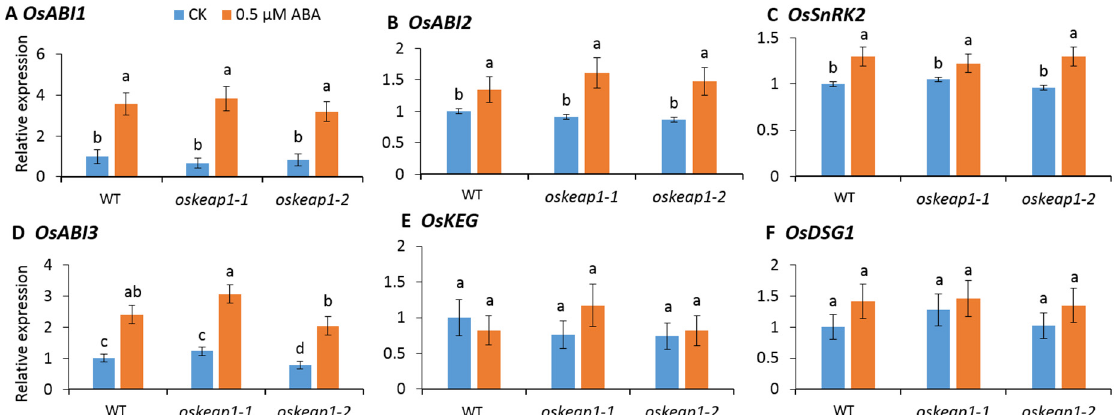
Figure 4. Relative expression of genes involved in the ABA signal transduction in seeds 4 days after germinating on a 0.5 MS medium without abscisic acid (ABA) (CK) or with 0.5 µM ABA. The expression levels of the same gene in different materials were compared with the wild-type (WT) germinated without ABA (its level was set as 1). OsACTIN was used as an internal reference. Data are shown as the mean ± standard error of three biological repeats. One-way ANOVA was performed for the statistical analysis, where different letters represent significant differences ( p ≤ 0.05).